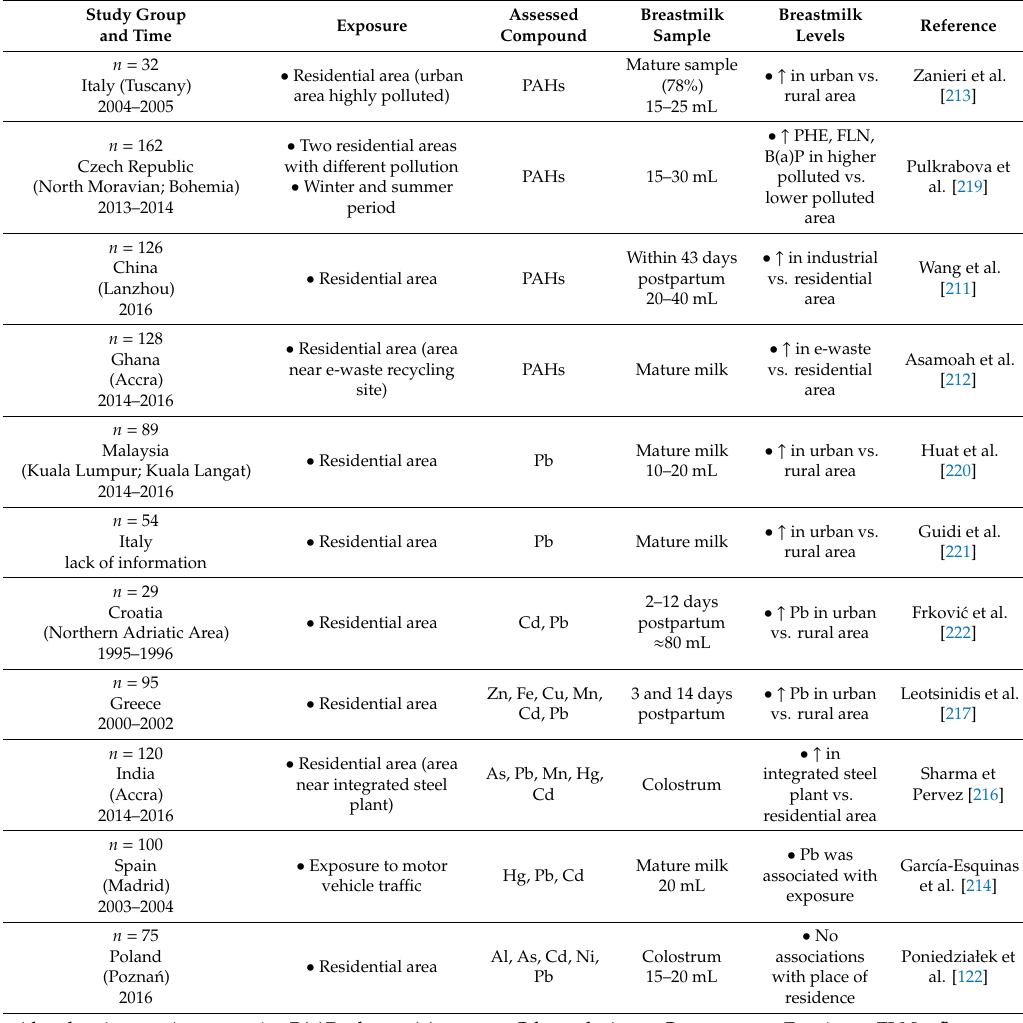
Table 4. Studies investigating the influence of maternal air pollution exposure on breastmilk chemical